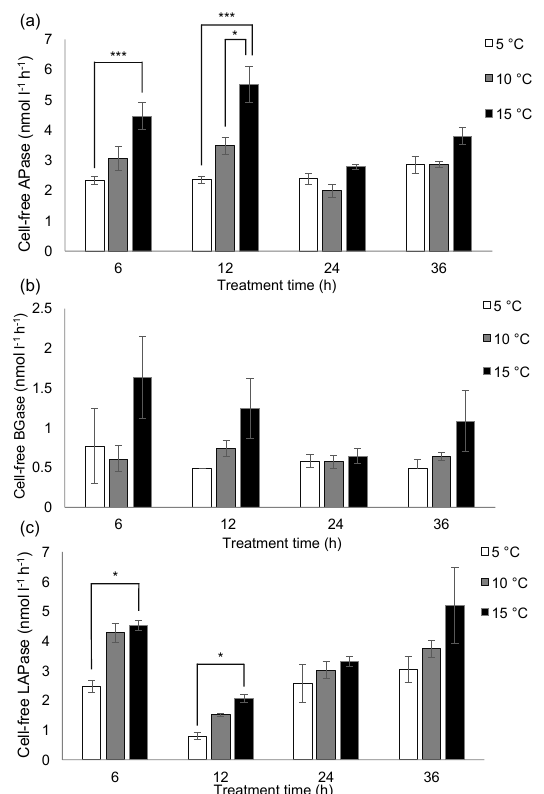
Figure 2. Results from temperature modification experiments Figure 2. Bar graphs of results from temperature experiments showing the mean cell-freeextracellular enzyme activity rate with standard error bars for alkaline phosphatase(a), β-glucosidase(b)and leucine aminopeptidase(c), under high showing the mean ( ± SE) cell-free extracellular enzyme activity temperature treatments [orange] and low temperature treatments [blue] in comparison to the ambient control treatments [grey]. Stars above graphs represent individual significant effects between treatments in post hoc Tukey tests (*<0.05, for alkaline phosphatase (a) , beta-glucosidase (b) , and leucine **<0.01, ***<0.001) (N=3). aminopeptidase (c) , under high (15 ◦ C) and low temperature (5 ◦ C) treatments in comparison to ambient controls (10 ◦ C). Asterisks above bars represent individual significant effects between treat- ments in post hoc Tukey test ( ∗ <0.05, ∗∗ <0.01, and ∗∗∗ <0.001) ( N =